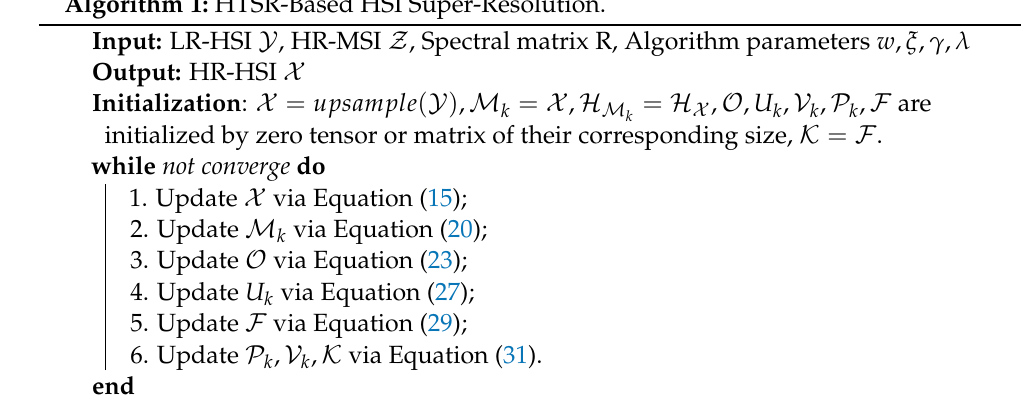
Algorithm 1: HTSR-Based HSI